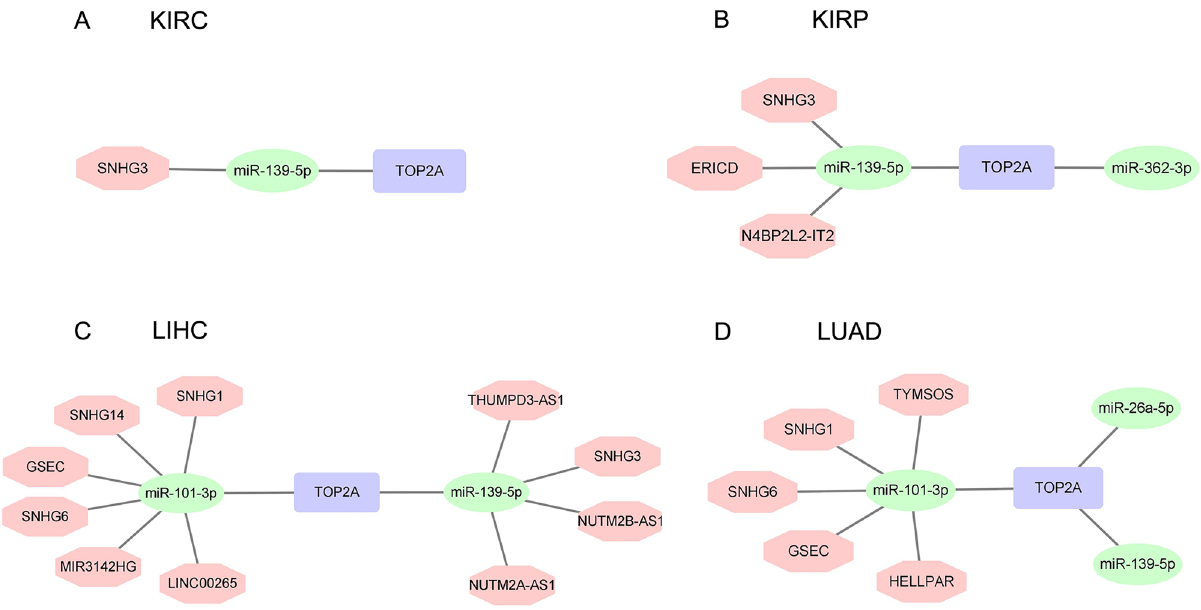
Figure 7. Predictive ceRNA networks of CCNA2 in KIRC KIRP, LIHC and